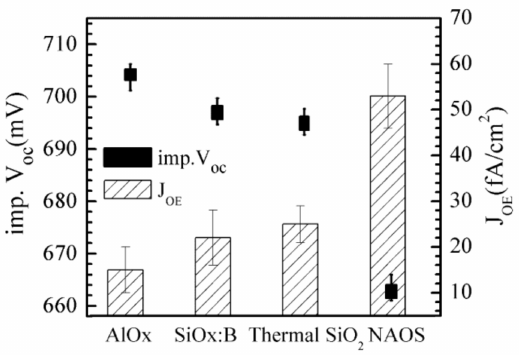
Figure 8. Comparison of J 0 E and implied V oc with different passivation layers.